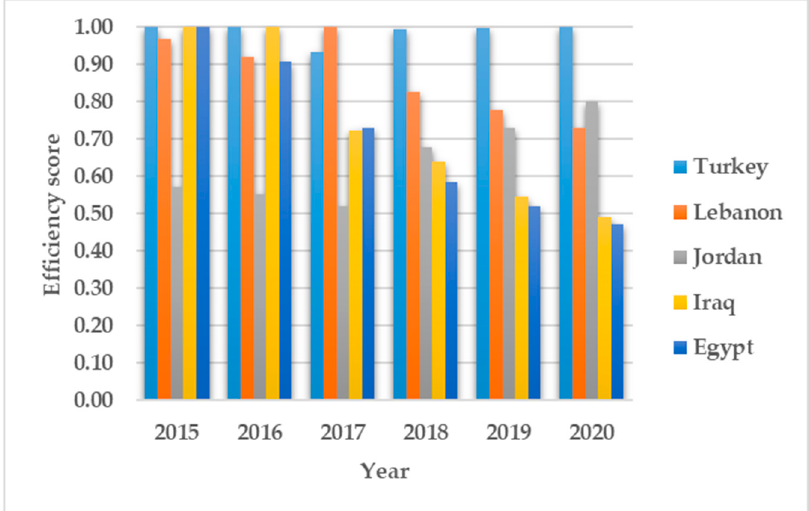
Figure 3. Pure technical efficiency scores.